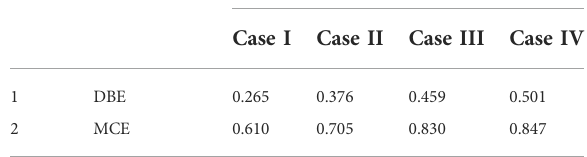
TABLE 8 Direct damage loss